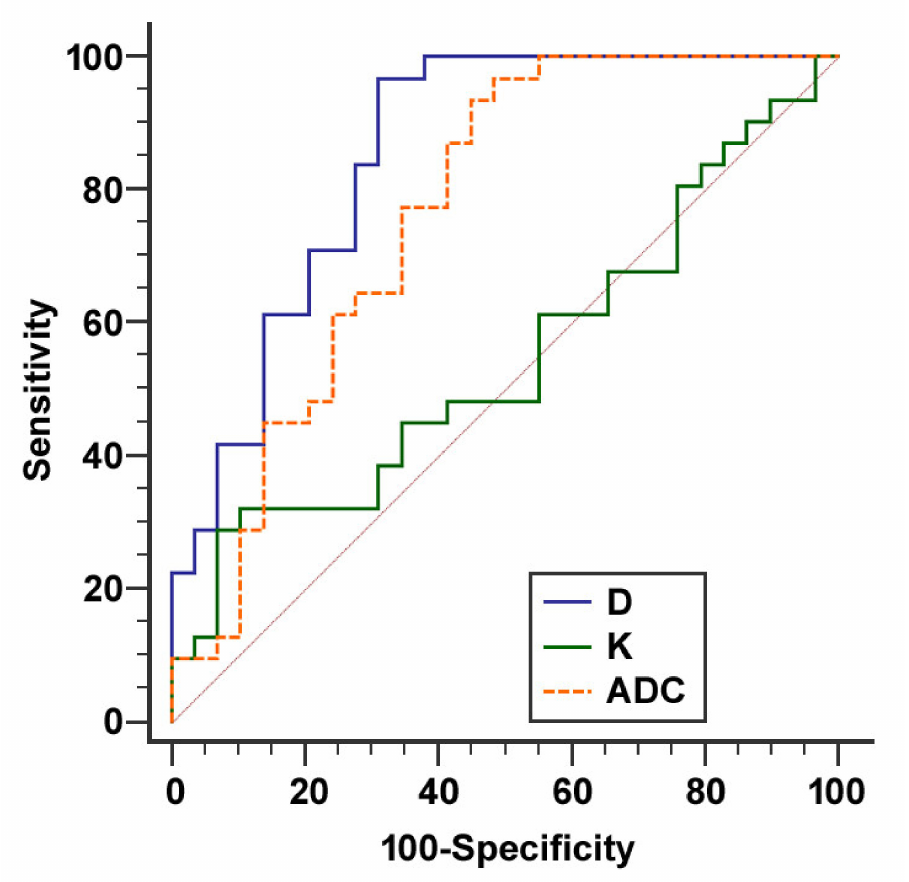
Figure 2. ROC curves for di ff erentiation of tumors from upstream parenchyma using D, K, and ADC. D showed highest diagnostic accuracy with an AUC of 0.854 (95% CI: 0.739 to 0.932, p < 0.001). Due to the small sample size of patients with downstream parenchyma ( n = 8), ROC curve analysis was not performed for distinguishing tumors from downstream